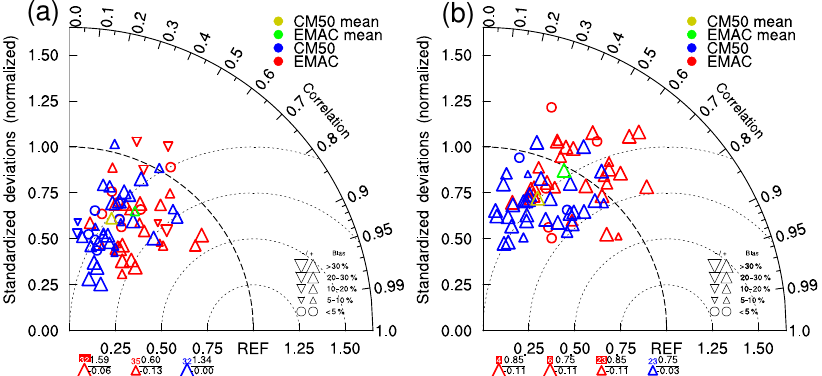
Figure 8. Taylor diagram of ground-level ozone concentrations for June (a) and December (b) 2008. The results for EMAC are shown in red, for CM50 in blue. The mean over all stations is coloured in green for EMAC and in yellow for COSMO/MESSy. The size of the symbols indicate the bias in percent; upward symbols signify a positive bias, downward symbols a negative bias. The symbols below the horizontal axis indicate the stations which are out of range. The coloured number provides the number of the station, the upper black number depicts the normalised standardised deviation and the lower number shows the correlation coefficient at the